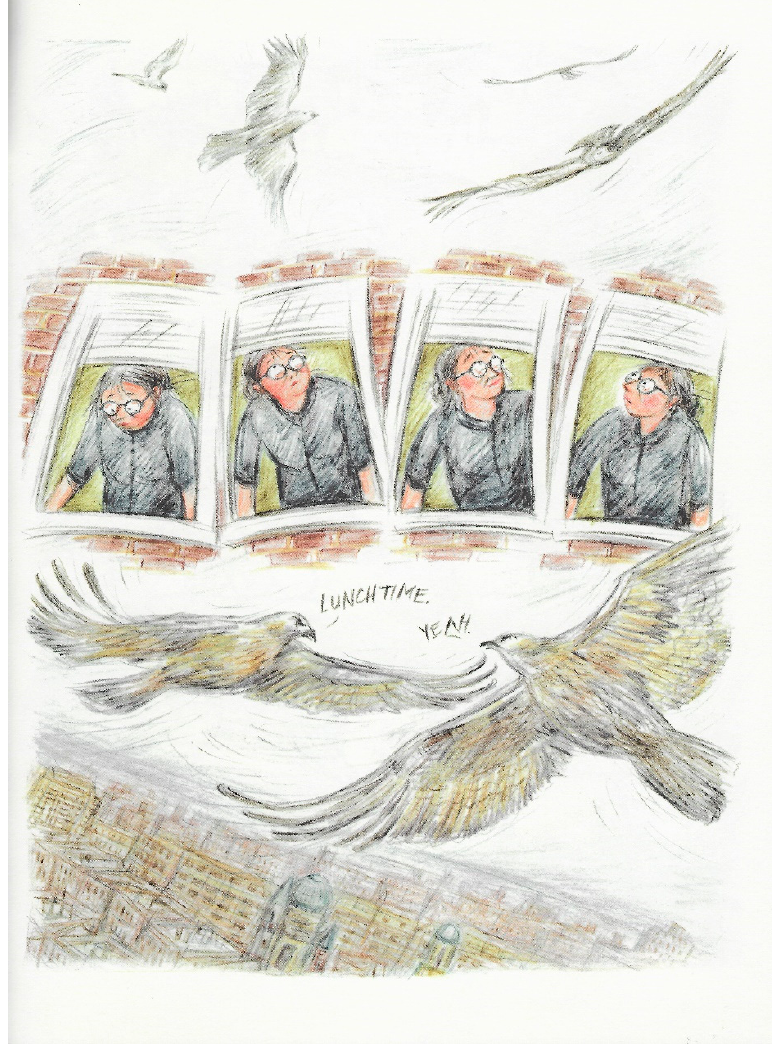
Figure 7. Letting It Go (Katin 2013). Reproduced by permission of Miriam Katin.